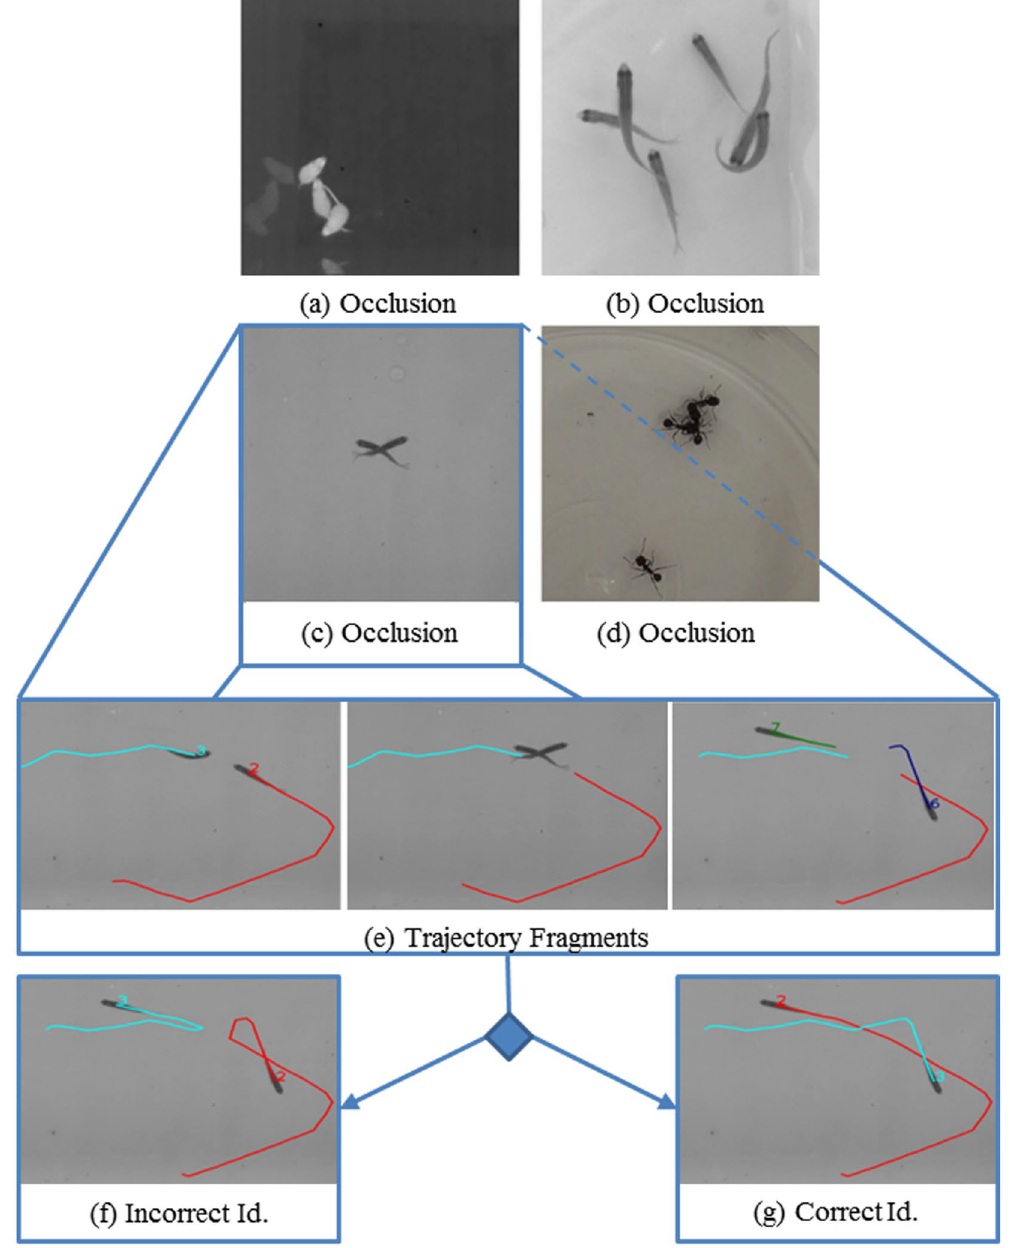
datasets used in this study: ( a ) Mice3 26 , ( b ) Zebrafish11 18 , ( c ) Zebrafish5 6 , ( d ) Ant5 6 . For the occlusion shown in ( c ), trajectory fragments before and after the occlusion are shown in ( e ). To solve the occlusion, the correct fragments should be merged. An incorrect identification is shown in ( f ) and the correct identification is shown in ( g